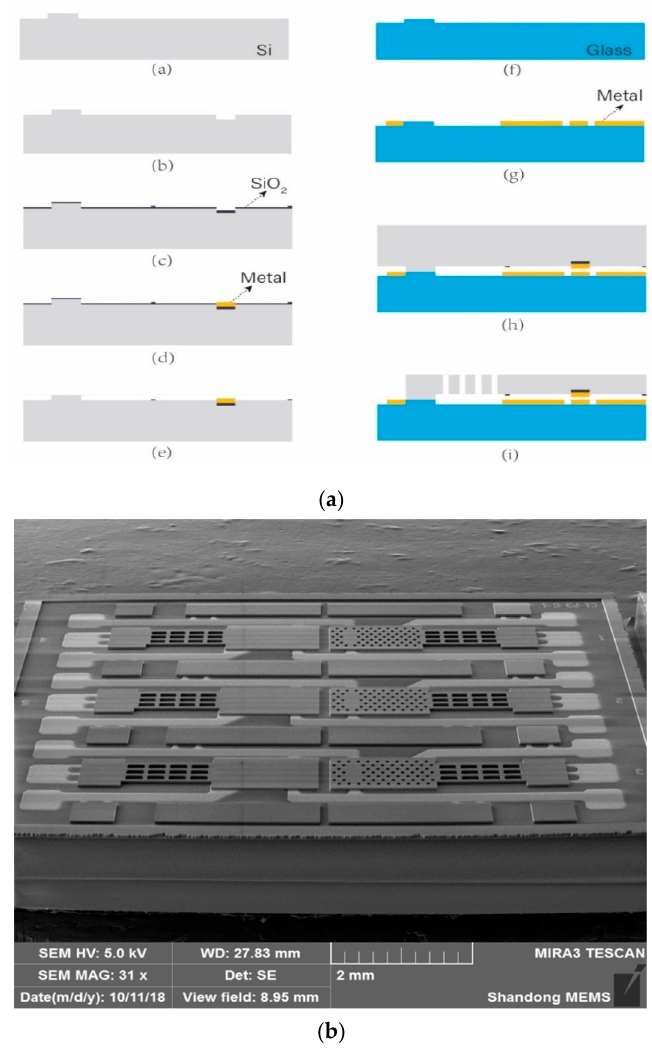
Figure 6. Microfabrication process and SEM image of the MEMS relay array. ( a ) Microfabrication process of the proposed MEMS relay array; ( b ) SEM image of the MEMS relay array.